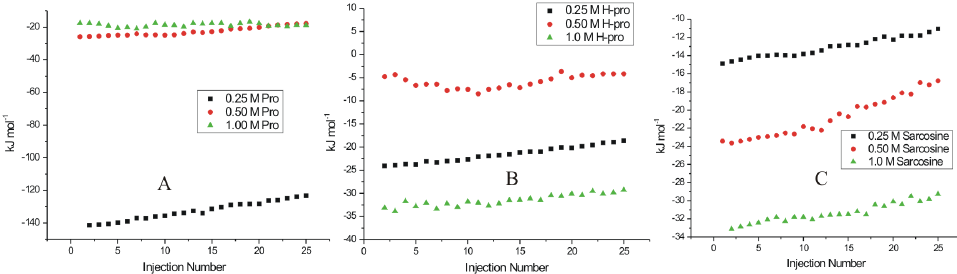
Figure 6. ITC profiles for the titrations of lysozyme at nucleation stage (after 48 h of incubation) with (A) L-proline (B) 4-hydroxy-L- proline and (C) sarcosine at 25 6 C.